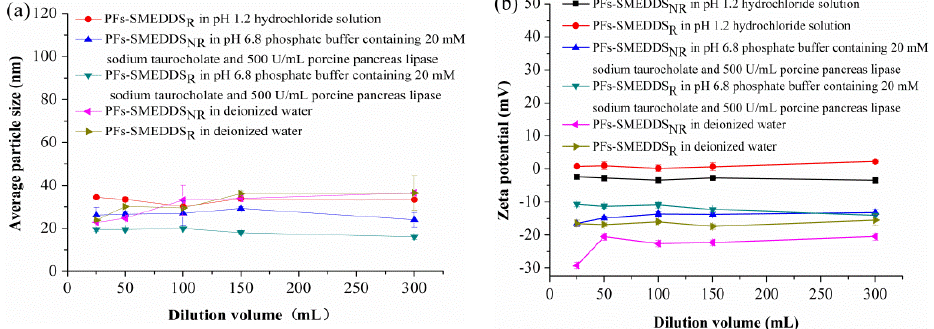
Figure 3. Effects of the volume of different media on average particles sizes ( a ) and zeta potentials ( b ) of pueraria flavone (PF)-loaded SMEDDS using NaTC and Cremophor RH 40 as mixed surfactants (PFs-SMEDDS NR ) and with Cremophor RH 40 only (PFs-SMEDDS R ) (mean ± SD, n = 3).